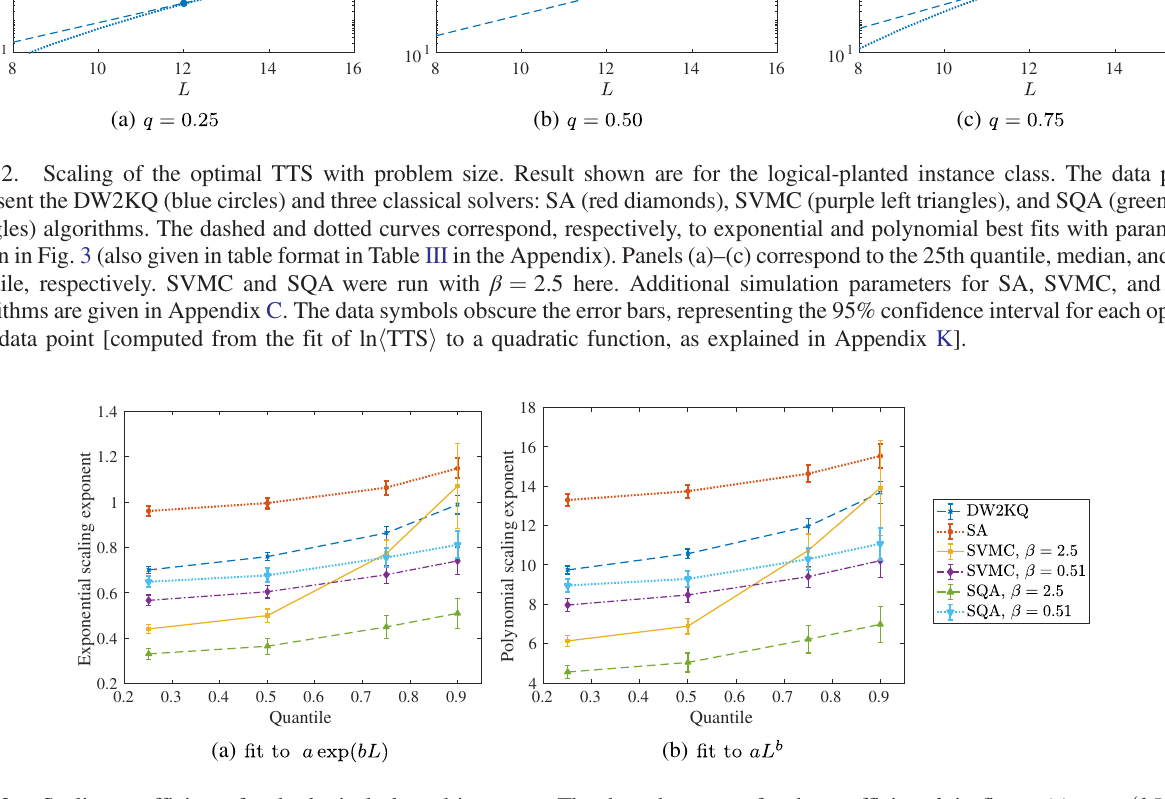
FIG. 3. Scaling coefficients for the logical-planted instances. The data shown are for the coefficient b in fits to (a) a exp ð bL Þ and (b) aL b for the logical-planted instances using L ∈ ½ 12 ; 16 (cid:2) for different quantiles and different solvers. Results are shown for the DW2KQ, SA (with a final inverse temperature of β ¼ 5 ), SVMC, and SQA for two different inverse temperatures. The value β ¼ 0 . 51 corresponds to the operating temperature of the DW2KQ of 15